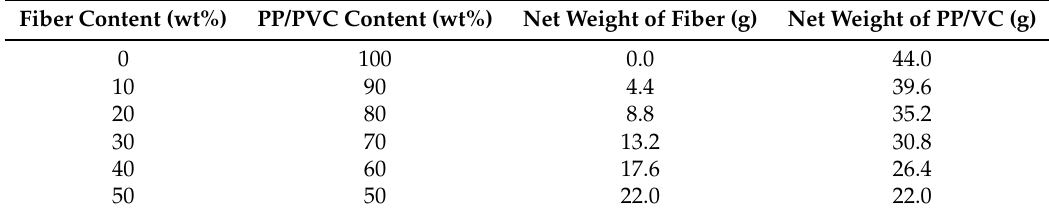
Table 1. Formulation for PP and PVC mixture with cotton